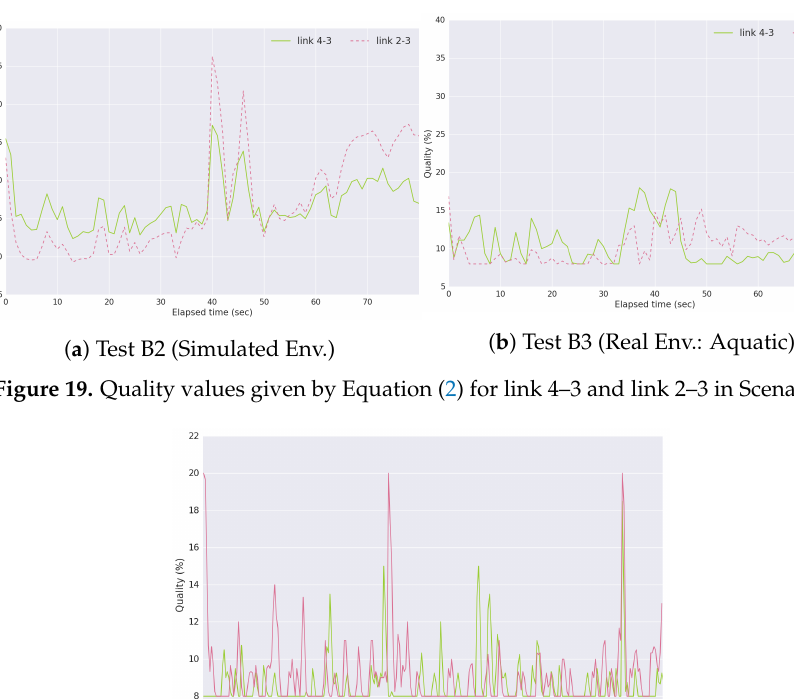
Figure 18. Delivery Ratio for Scenario B: ratio between the delivered data packets to a gateway and the overall data packets.